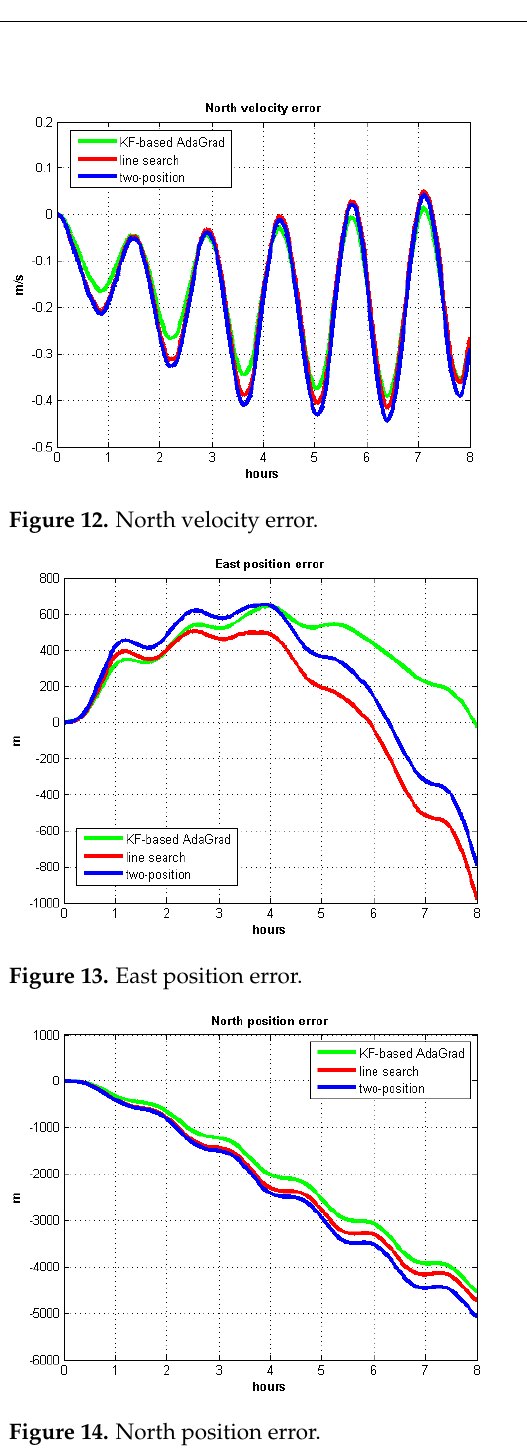
Figure 14. North position